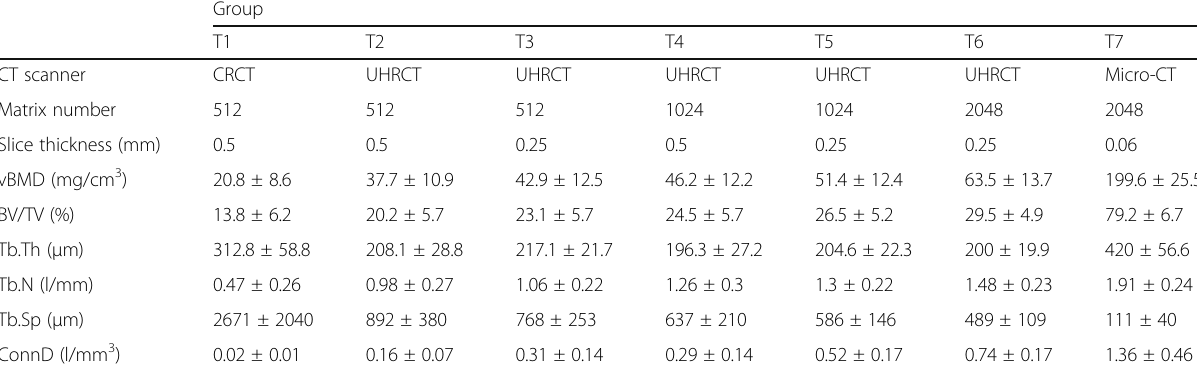
Table 3 Comparison of tiger vertebral microarchitectural parameters obtained with different CT scanners, matrix numbers, and slice thicknesses ex vivo